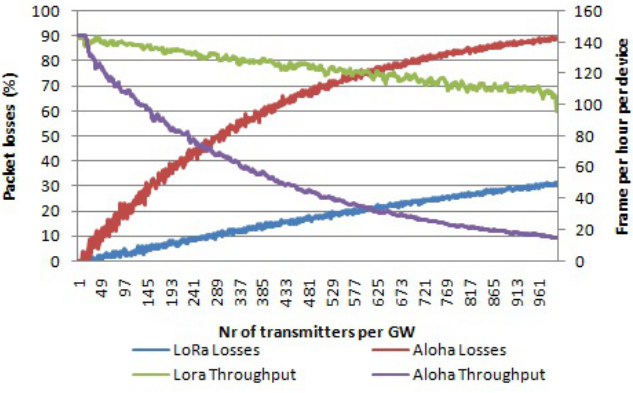
Figure 15. Comparison between LoRa and pure Aloha in terms of percentage of packets lost and average throughput per device. Multiple channels, multiple SFs and payload size of 20 bytes.